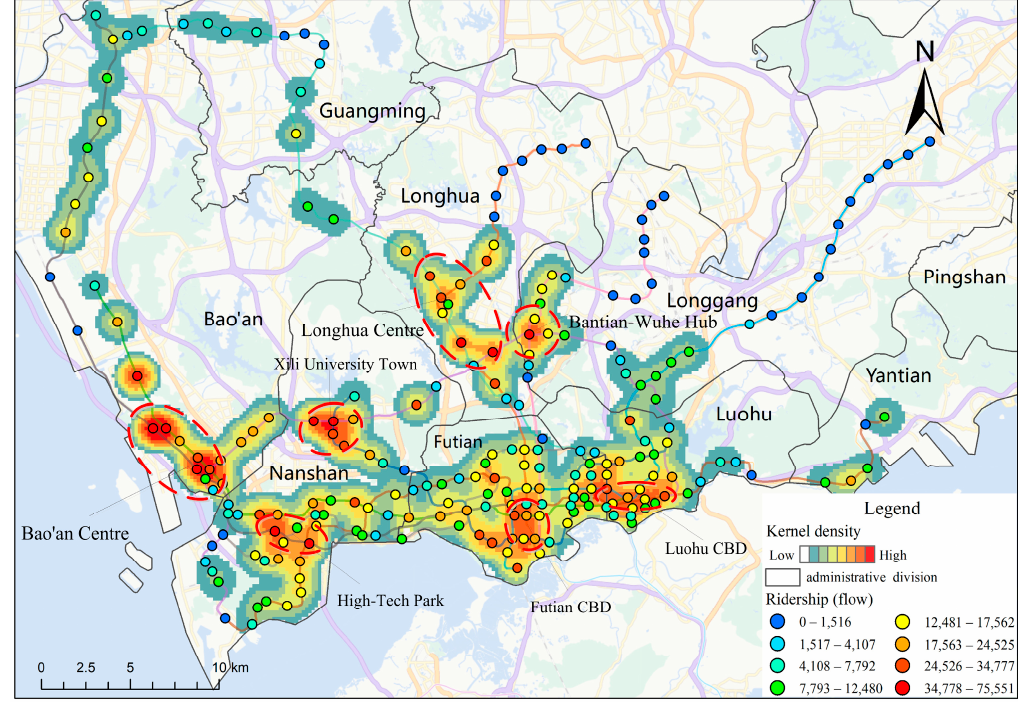
Figure 9. Statistics and kernel density distribution of DBsMIC’s full sample ridership.